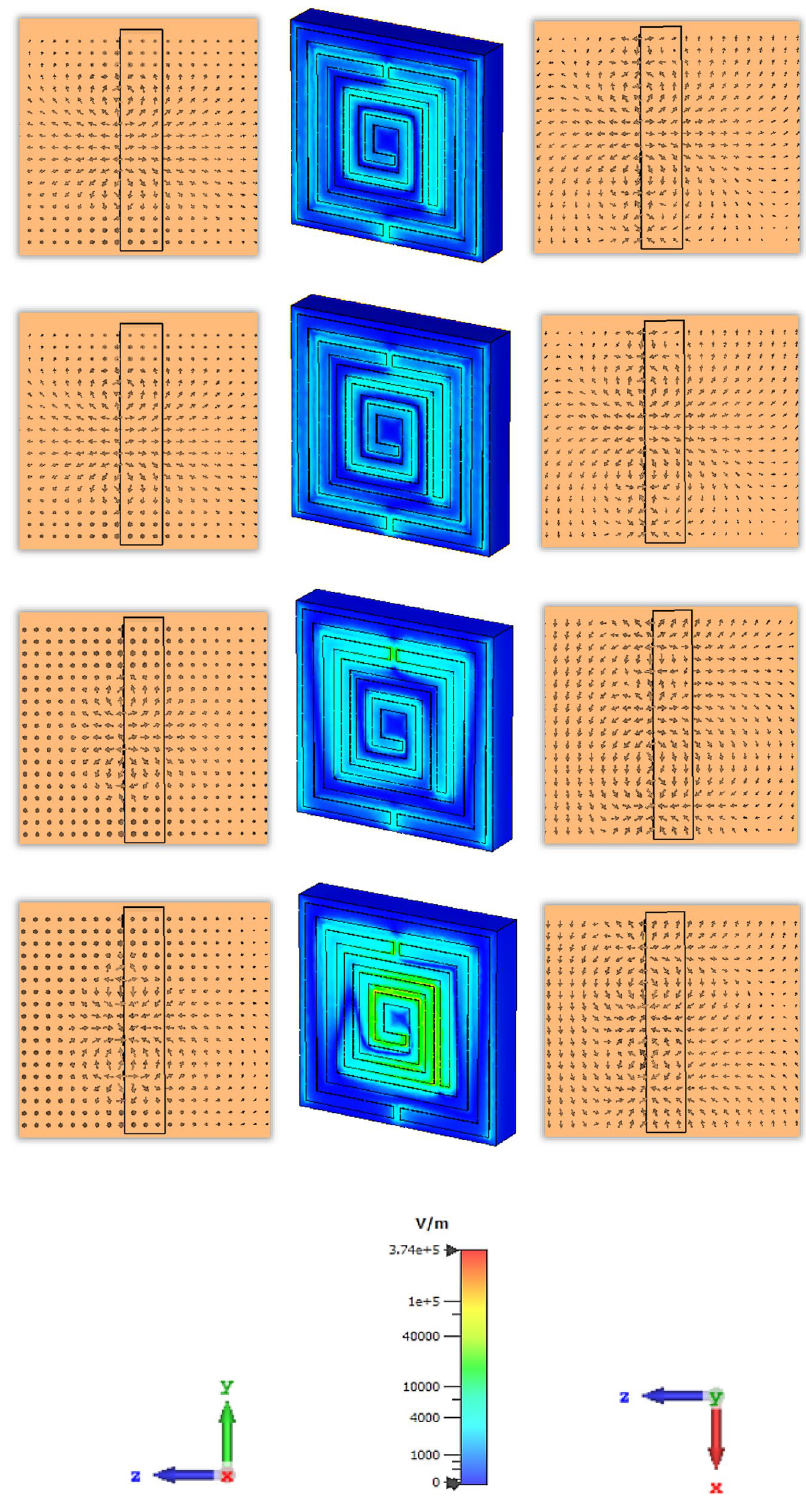
Figure 7. Electric field distribution in row-wise ascending from the top order for different resonant frequencies of 1.87, 2.55, 4.32, 5.46 GHz